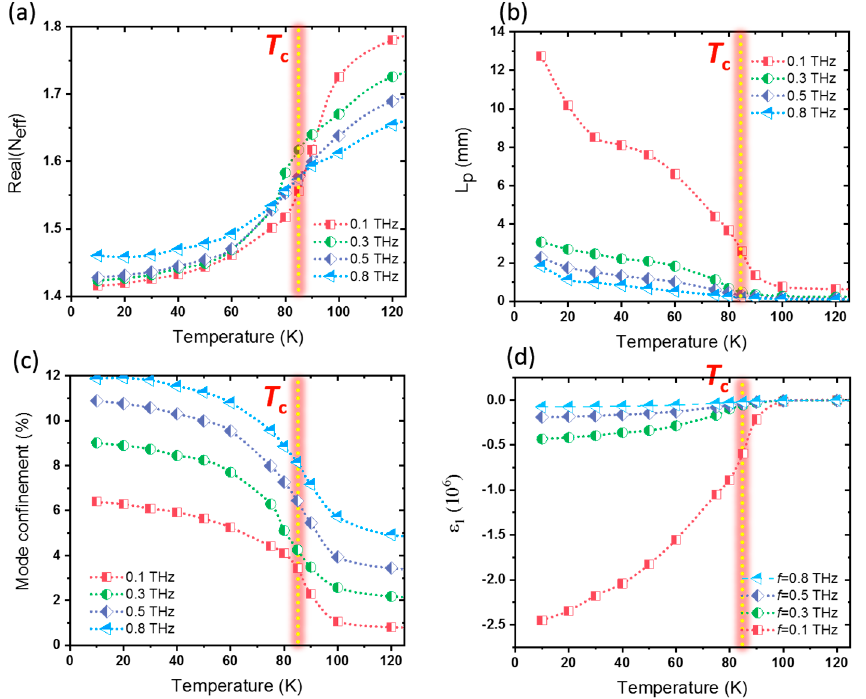
Figure 3. ( a ) Real part of the mode effective refractive index ( N eff ), ( b ) propagation length of SPPs ( L p ), ( c ) the mode confinement of the PSW as a function of temperature, and ( d ) the real part of BSCCO permittivity at different frequencies. The vertical dashed lines show the T c of BSCCO.